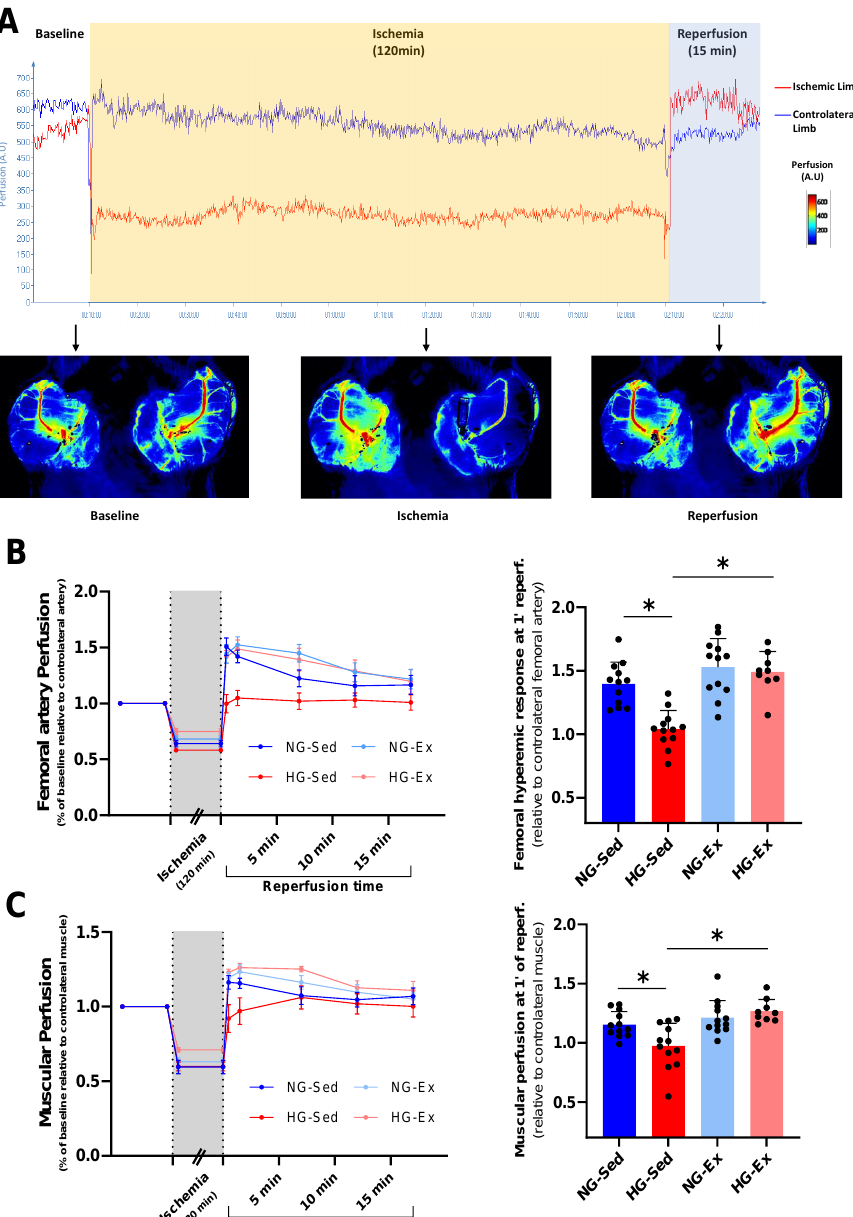
Figure 2. Beneficial impact of exercise training on the artery and downstream muscular perfusion in hy- perglycemic conditions. ( A ) Experimental protocol of vascular ischemia-reperfusion (120 min./15 min.) using laser Speckle contrast imaging to evaluate arterial and downstream muscular perfusion levels. Perfusion was evaluated in the ischemic-limb (red) and the contralateral limb (blue). ( B ) Femoral artery perfusion kinetics evaluated using laser speckle contrast imaging during the ischemia-reperfusion proto- col (left panel) and hyperemic response evaluated through vascular perfusion at 1 min of reperfusion (right panel). ( C ) Muscular perfusion during ischemia-reperfusion evaluated using laser speckle contrast imaging (left panel) and hyperemic response evaluated through muscular perfusion at 1 min of reperfu- sion (right panel). n = 10–12 rats per group. NG: normoglycemic; Sed: sedentary; HG: hyperglycemic; Ex: exercise training. *: p < 0.05. All values are expressed as the mean ± SEM. Comparisons of multiple experimental conditions were performed using analysis of variance (ANOVA) or repeated measures ANOVA followed by Tukey’s post hoc